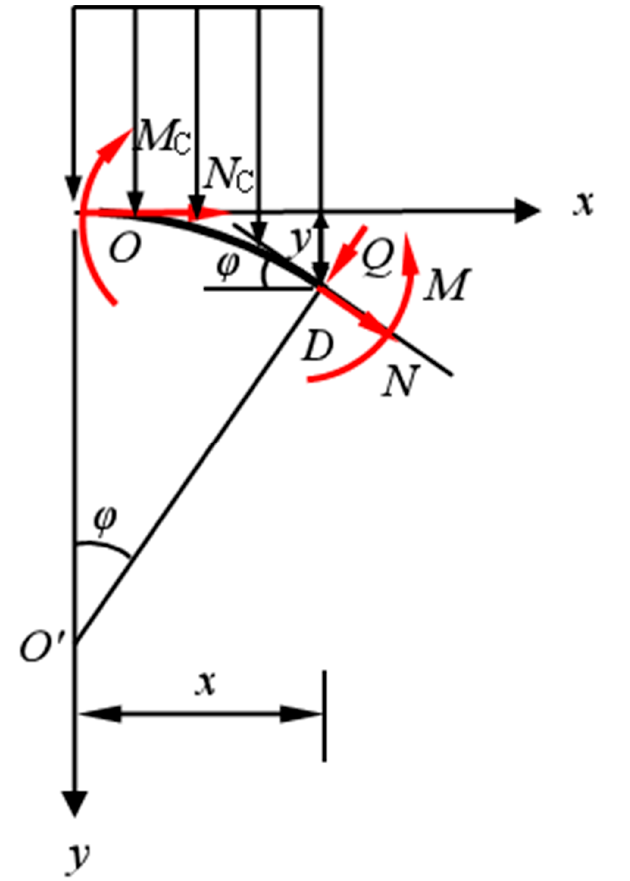
Figure 6. Force diagram of any section of the right half-arch ring. Bending function